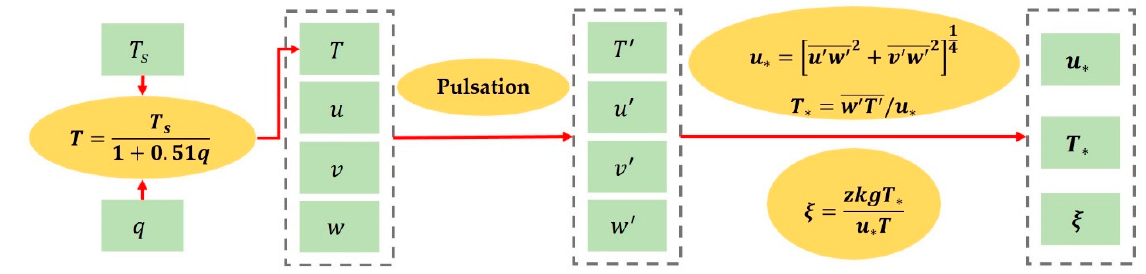
Figure 2. Flow chart of the turbulence-scale-parameter calculation process .